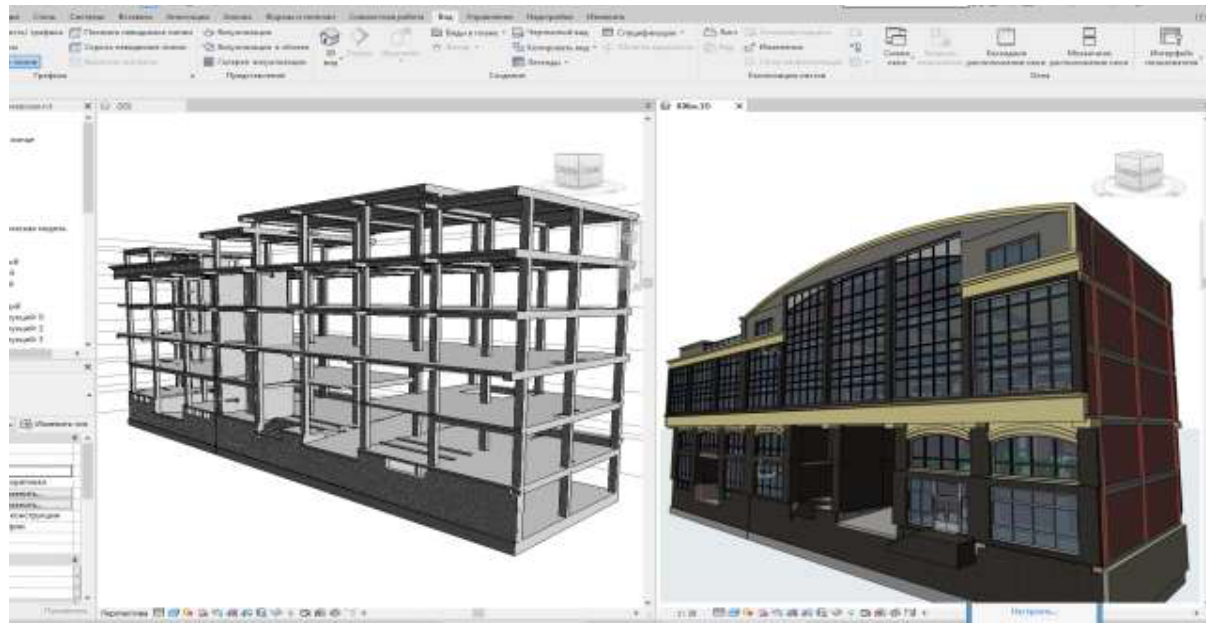
Figure 2 . BIM model. Reinforced concrete frame and architectural